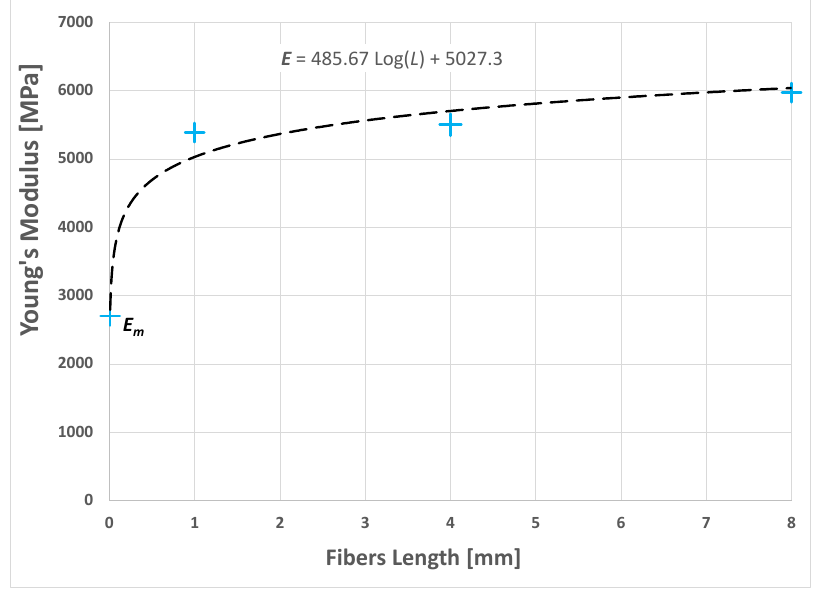
Figure 9. Graph of the resulting Young’s modulus of the composite as the average length of the short sisal fibers varied.